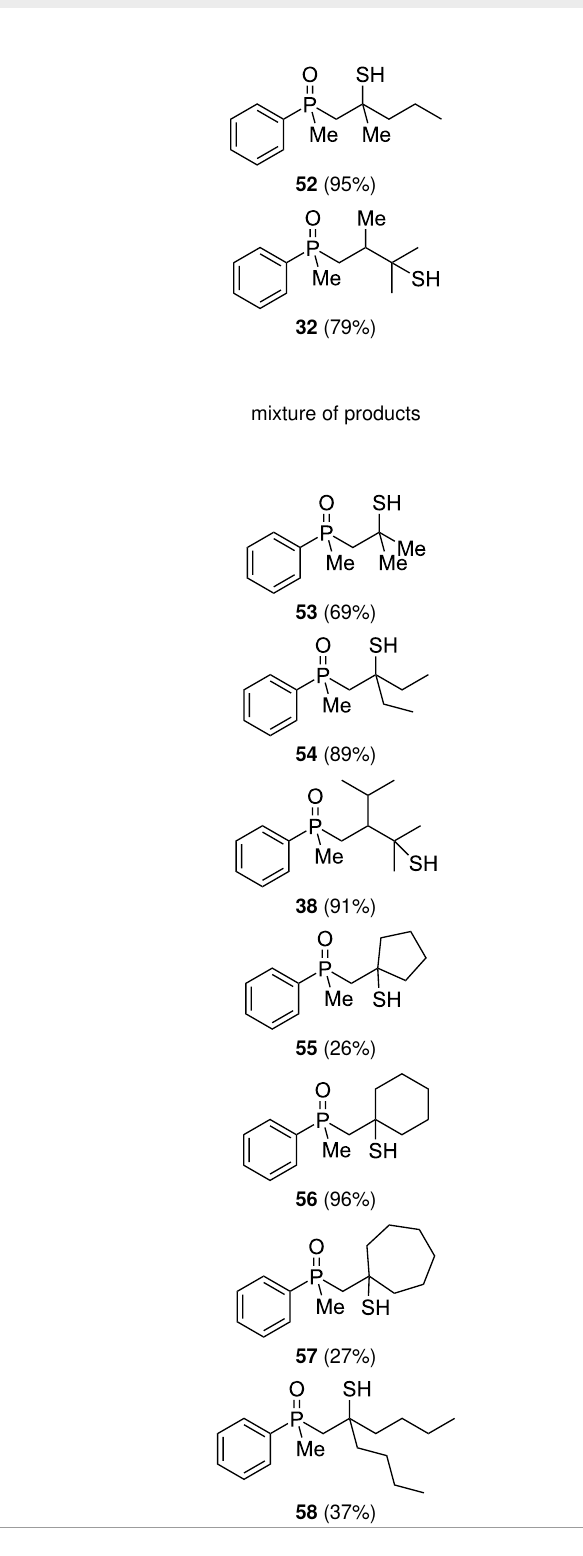
Table 3: Reaction of β -hydroxyalkylphosphine sulfides with Brønsted-acidic H 2 SO 4 .